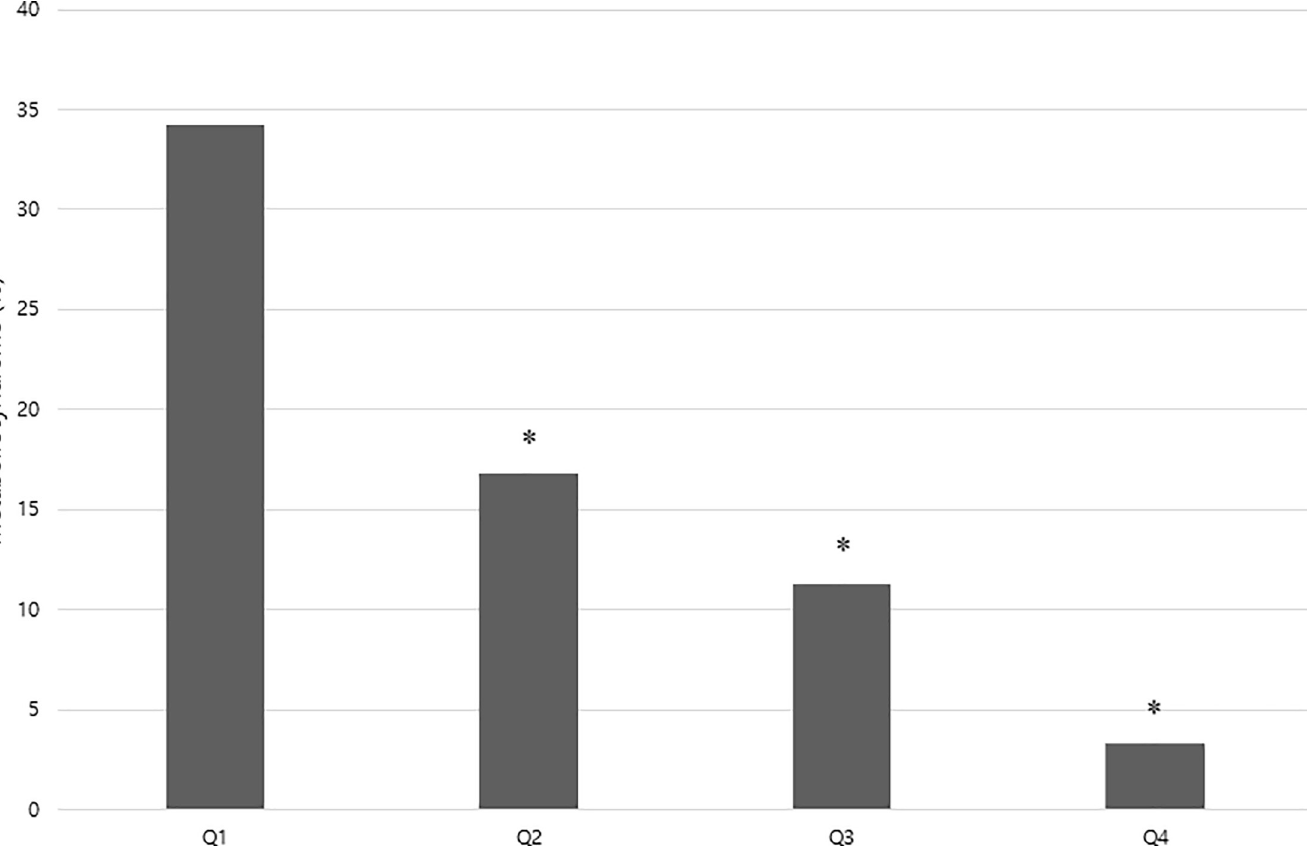
Fig 3. Prevalence of metabolic syndrome according to ASM% (appendicular skeletal muscle mass x 100/Weight) quartiles. � Significantly lower compared with the Q1 (P < 0.001).